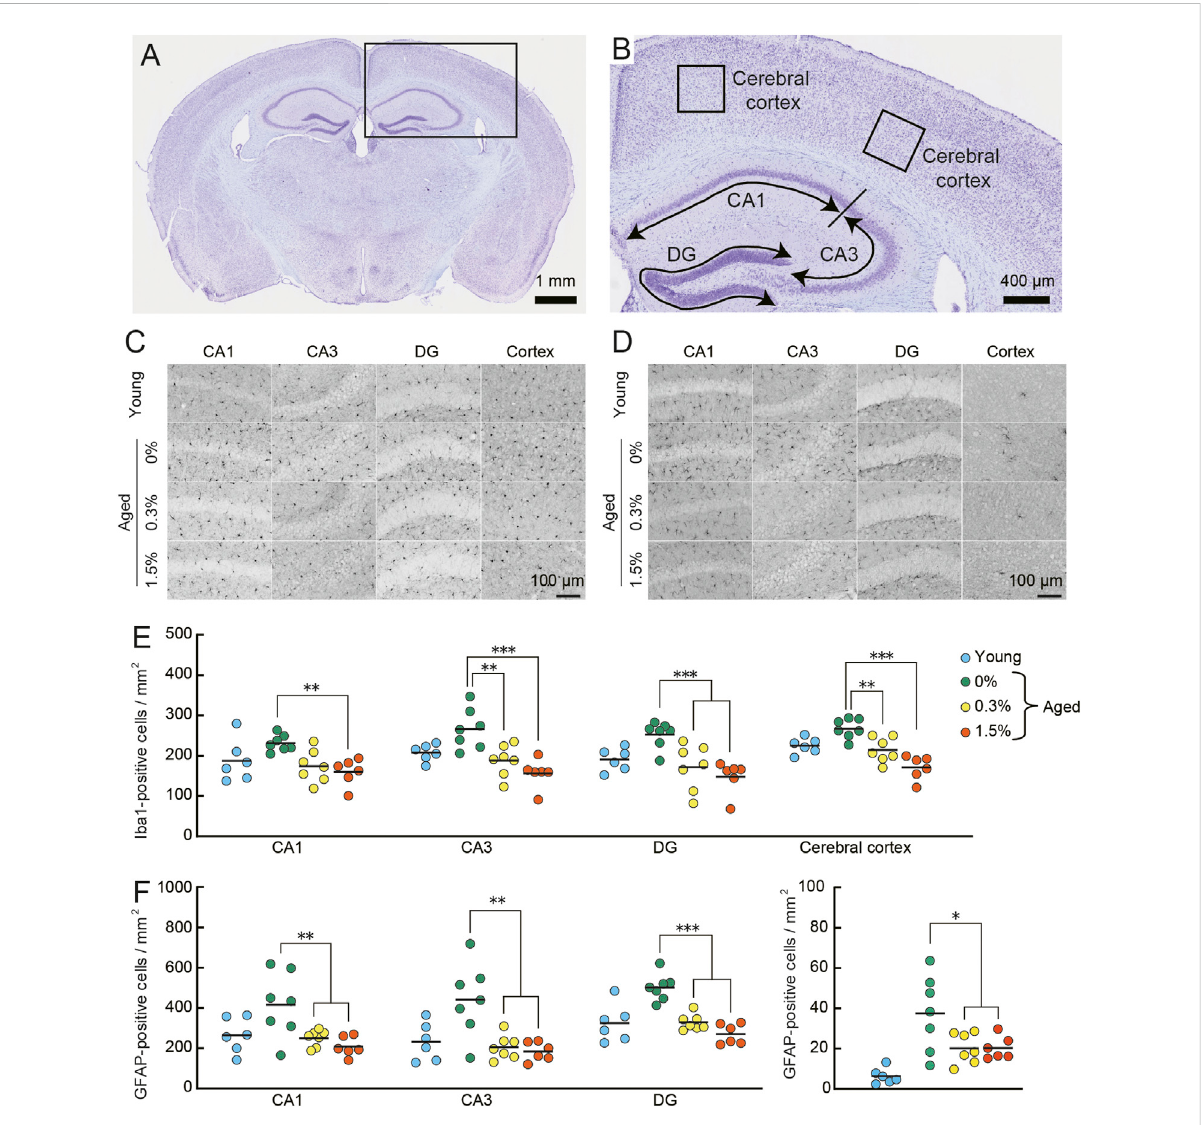
FIGURE 8 Cilostazol reverses neuroin fl ammation in aged mice. Mouse brains were processed for immunohistochemical analysis and photo- documentationof Iba1-and GFAP-positive cells inthehippocampus and cerebral cortex after completing thecontext-dependent fearmemory test. (A) Light photomicrograph of a Nissl-stained coronal section from an aged mouse showing the analysis area (box) in the brains for quantitation in cerebral cortex and hippocampus. Scale bar is 1 mm. (B) Higher magni fi cation photomicrograph of analysis areas in hippocampus (CA1, CA3, DG) and cerebral cortex. Scale bar is 400 μ m. (C,D) Representative high-magni fi cation images of Iba1-positive (C) and GFAP-positive (D) cells in the indicated brain regions of an aged mouse receiving the indicated dosage of cilostazol. Scale bars are 100 μ m for all images. (E) Scatter dot plot representing Iba1-positive cells in subregions of hippocampus and in cerebral cortex. Quantitative analysis using one-way ANOVA showed that 1 monthofcilostazoladministration signi fi cantly reducedthenumberofIba1-positivecellsinallsubregionsofthehippocampus(CA1, p < 0.01;CA3, p < 0.001;DG, p < 0.001)andthecerebralcortex( p < 0.001). (F) ScatterdotplotofGFAP-positive cells. Dueto majordifferencesbetweenthecortex andotherhippocampalregion,dataforcerebralcortexisshowninanindependentpanel.One-wayANOVAshowedthatthemeannumberofGFAP- positivecellsinagedmicereceivingcilostazolwassigni fi cantlylowerthanthatofthecontrolagedmice(CA1, p < 0.01;CA3, p < 0.001;DG, p < 0.001; cerebralcortex, p < 0.05).For (C – F) ,0%,0.3%,and1.5%representtheconcentrationoforallyadministeredcilostazol.Datafrom3-month-oldyoung mice (Young) are shown as a reference but not included in statistical analyses. *** p < 0.001, ** p < 0.01, * p < 0.05 compared with the control aged mice. Horizontal bars in panel E and F indicate mean